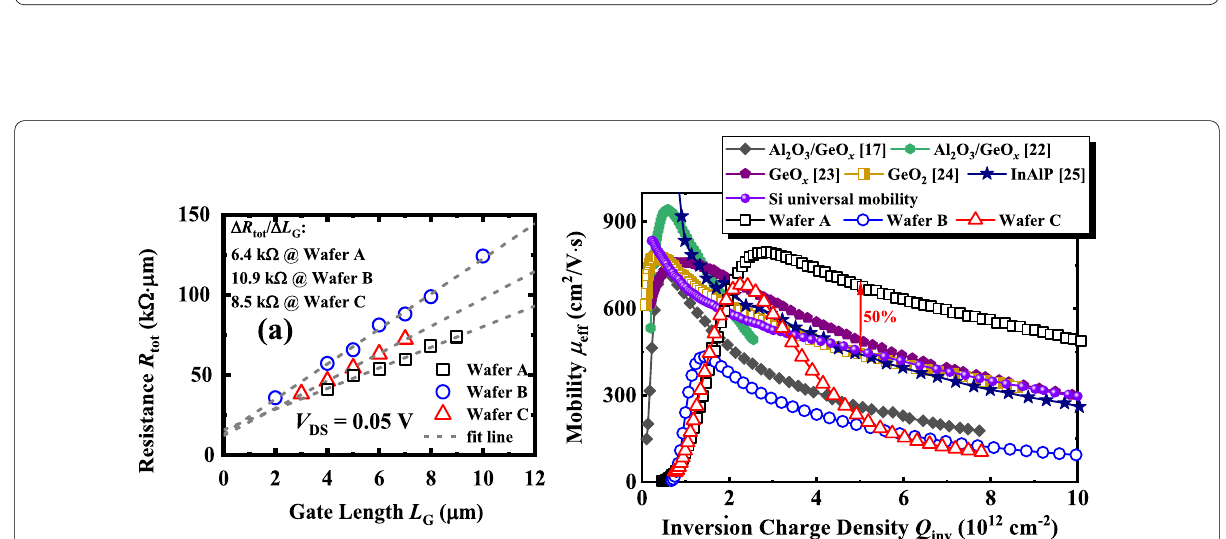
Fig. 5 a R tot versus L G curves for Ge nMOSFETs on wafers A, B, and C. The fitted line intersecting at the y-axis and the slope of linear fit lines are utilized to extract the R SD and R CH , respectively. b μ eff for the Ge nMOSFETs in this work versus previously published results for unstrained Ge transistors. The devices on wafer A show the improved μ eff than the Si universal mobility in the entire range of Q